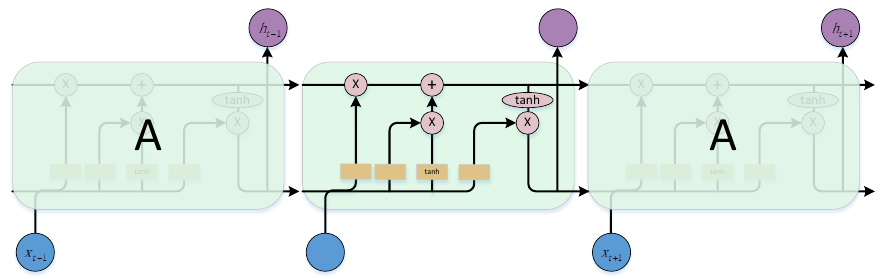
Figure 3. LSTM model structure.